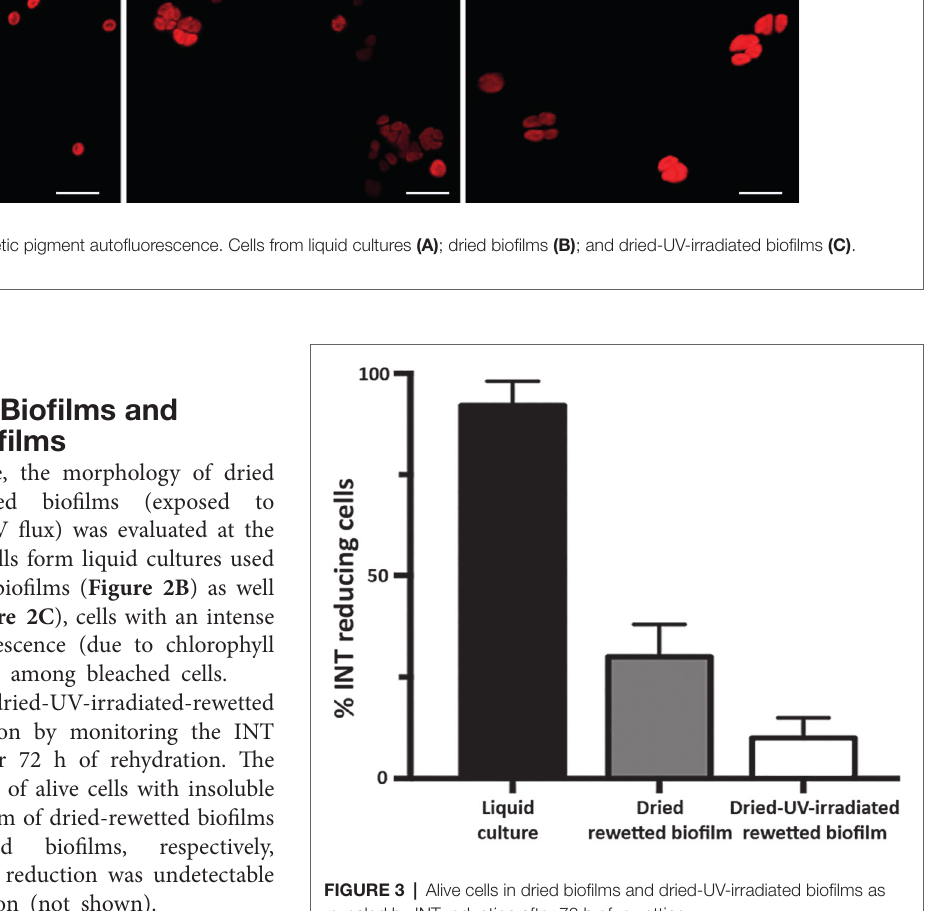
FIGURE 3 | Alive cells in dried biofilms and dried-UV-irradiated biofilms as revealed by INT reduction after 72 h of